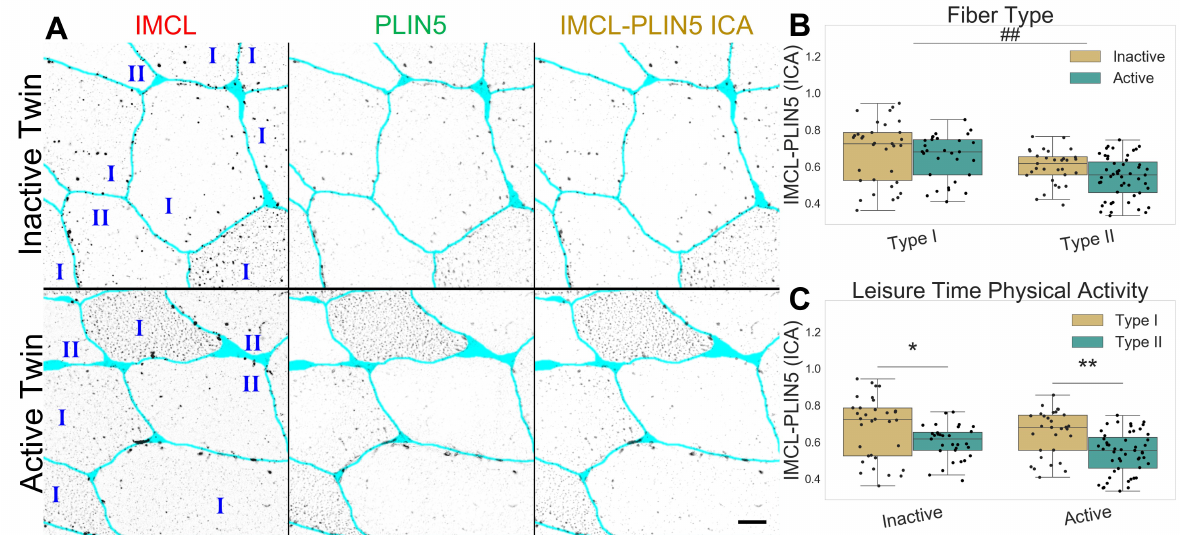
Figure 2. IMCL-PLIN5 intensity correlation analysis in twin pairs. ( A ) representative image showing differences between groups. Gray level indicates signal, cyan indicates segmented sarcolemma. Bar = 20 µm; ( B ) fiber type as main effect, with LTPA combined; ( C ) LTPA main effect, with fiber type combined. Main effect differences denoted with ## ( p < 0.001). Combined group differences denoted with * ( p < 0.01) and ** ( p < 0.001). Dots in ( B , C ) represents individual